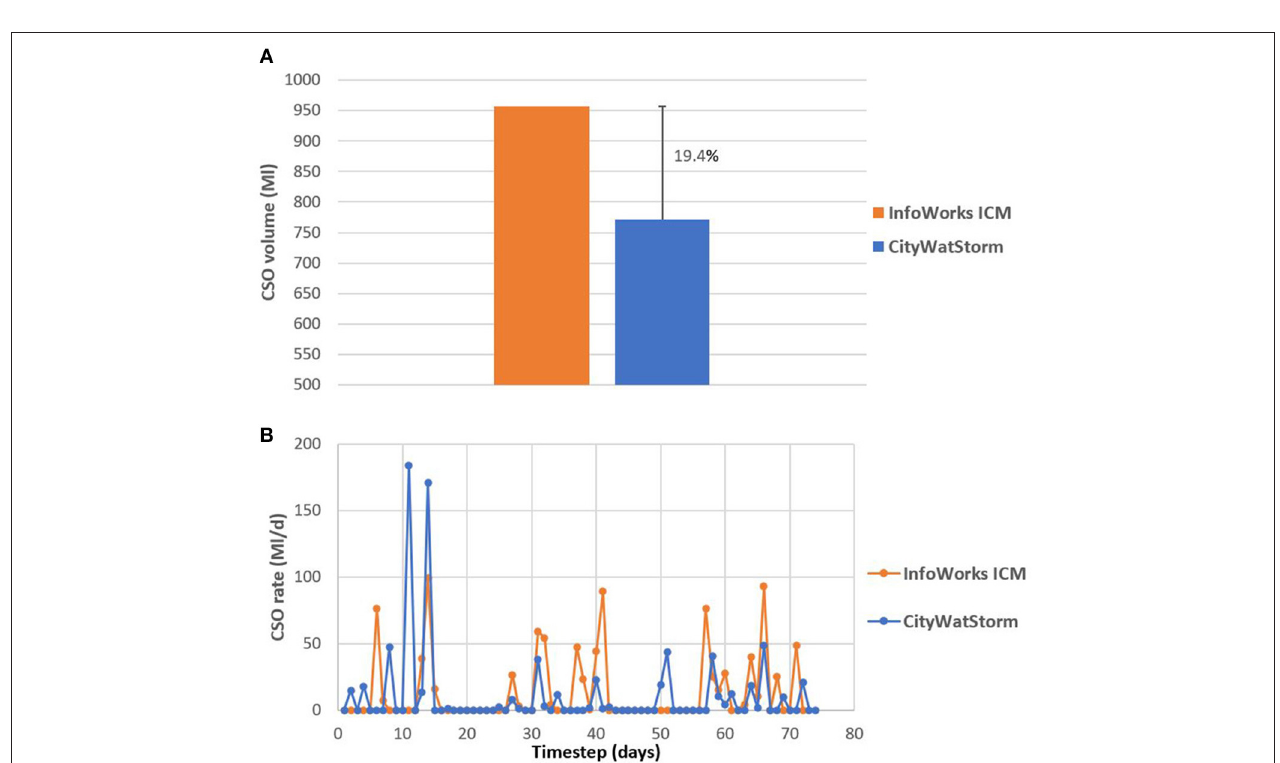
FIGURE 5 | CityWatStorm vs. InfoWorks ICM. (A) Total CSO comparison. (B) Time varying CSO comparison.